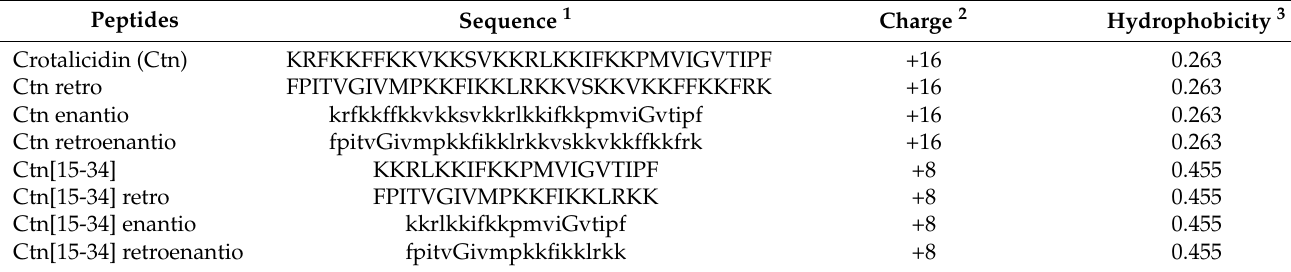
Table 1. Primary structures of crotalicidin, Ctn[15-34] and their